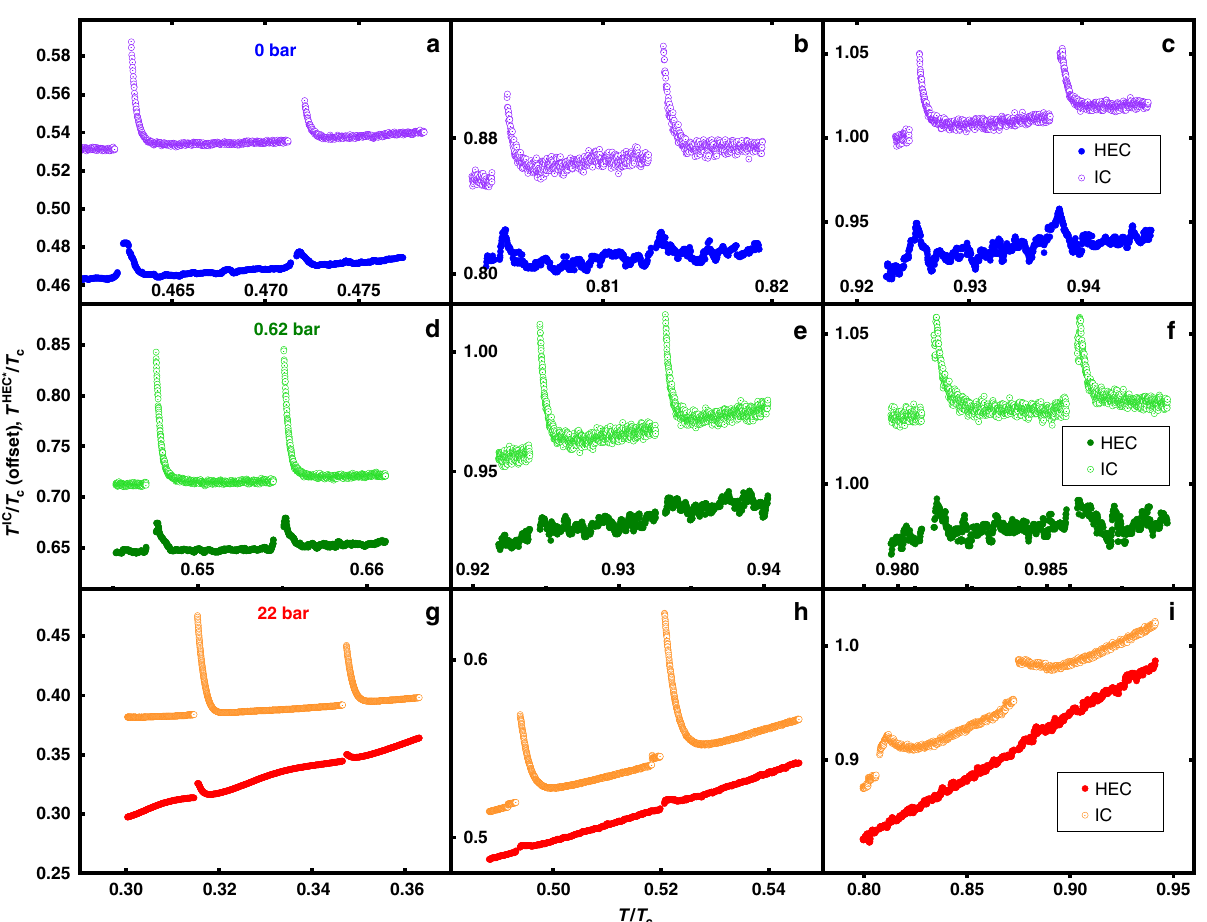
Fig. 7 Local temperatures of both forks after pulses at representative temperatures. The 3 × 3 panels ( a – i ) show the local temperature T HEC* / T c ( fi lled circles) compared to T IC / T c (open circles) (offset upward by 0.05 T IC / T c for clarity) against T / T c , the slowly rising temperature of the nuclear demagnetization stage. The top row shows three representative sets of pulses at 0 bar and near 0.45 T / T c ( a ), 0.8 T / T c ( b ), and 0.94 T / T c ( c ). The middle row ( d – f ) shows results for 0.62 bar, and the lower row shows results at 22 bar ( g – i ). Two different pulse durations were used accounting for differences in the initial temperature rise observed. Data obtained while cooling exhibits the same